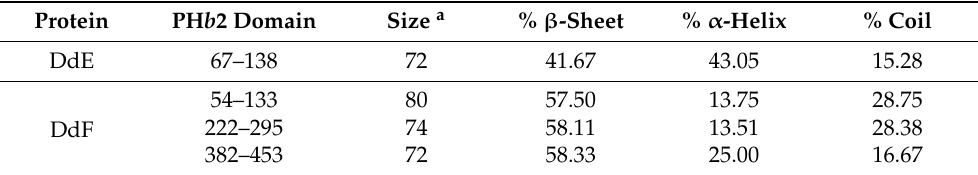
Table 2. Prediction of the secondary structure of DdE and DdF PH b 2 domains.